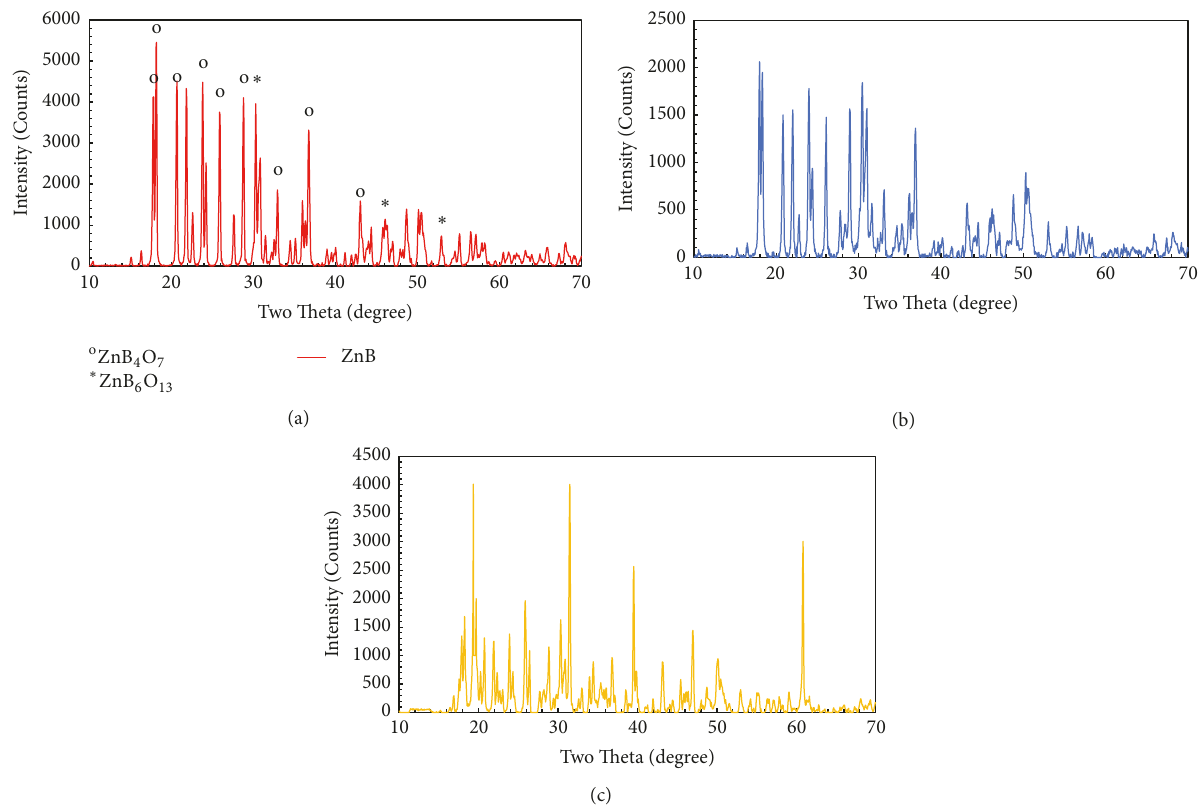
Figure 2: XRD patterns of ZnB (a) as received, (b) after milling, and (c) after milling (pH=4).